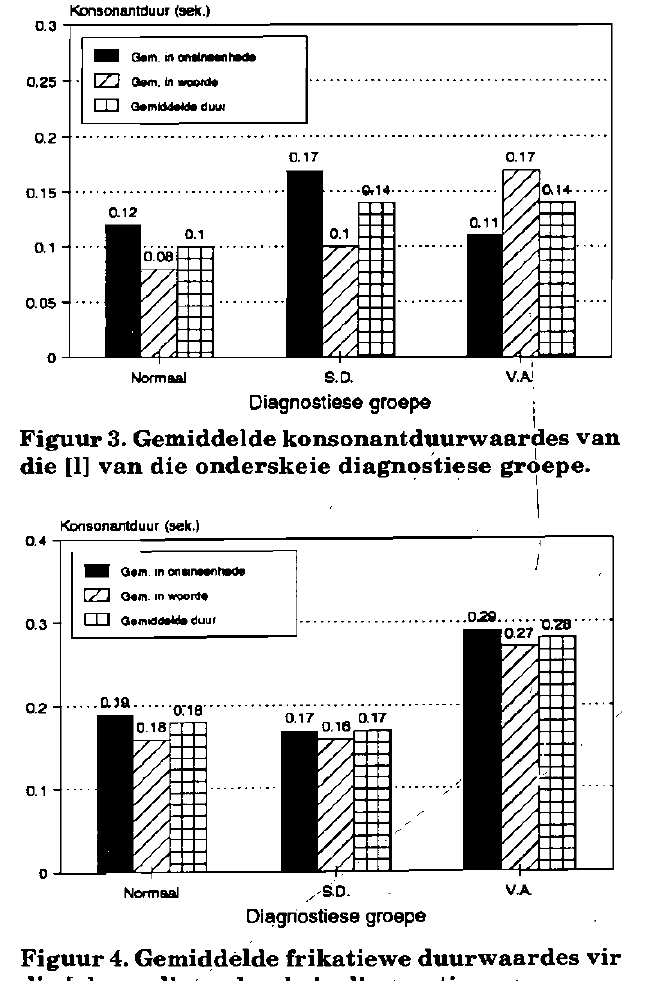
Figuur 4. Gemiddelde frikatiewe duurwaardes vir die [s] van die'onderskeie diagnostiese